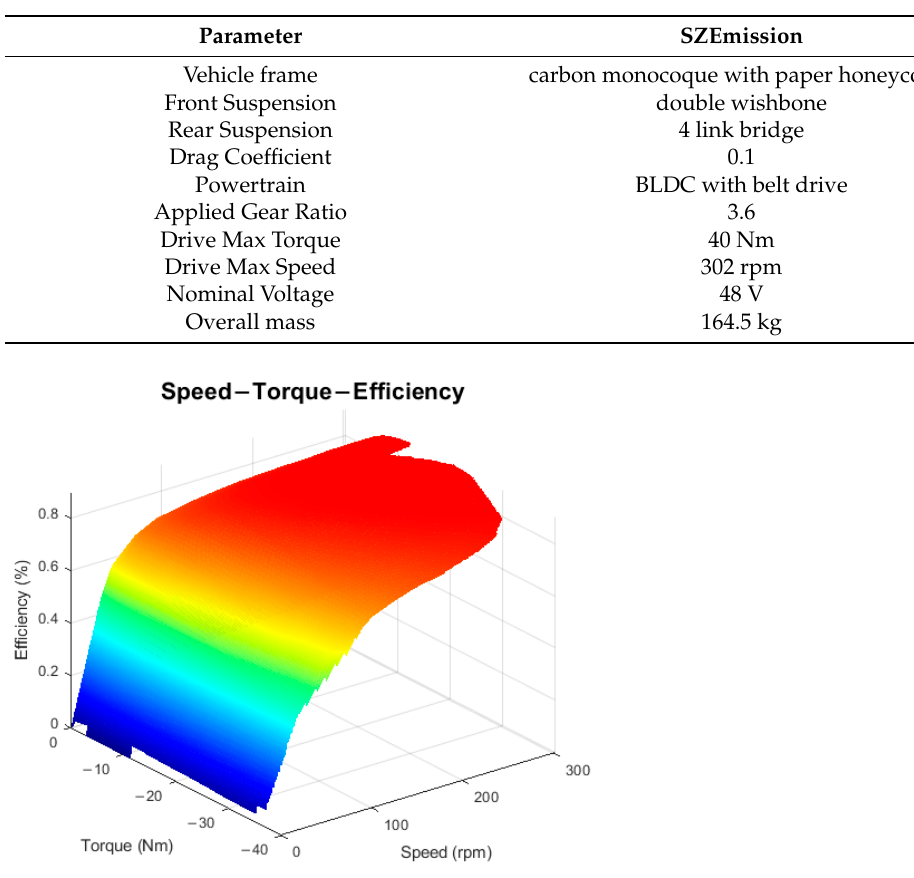
Table 1. Technical parameters of the SZEmission.